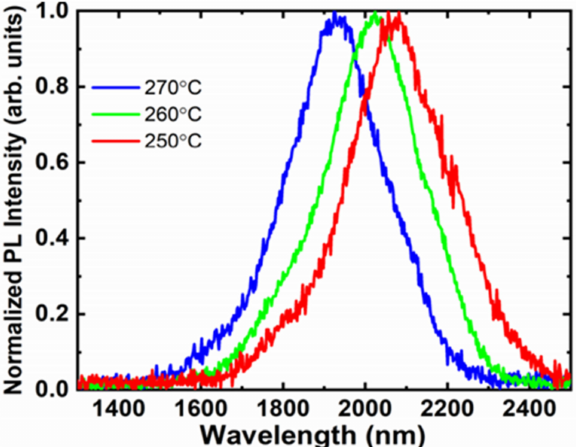
Figure 9. PL spectra for the GeSn grown at temperatures of 250, 260, and 270 ◦ C. Reproduced from [157], open access by ScholarWorks@UARK.